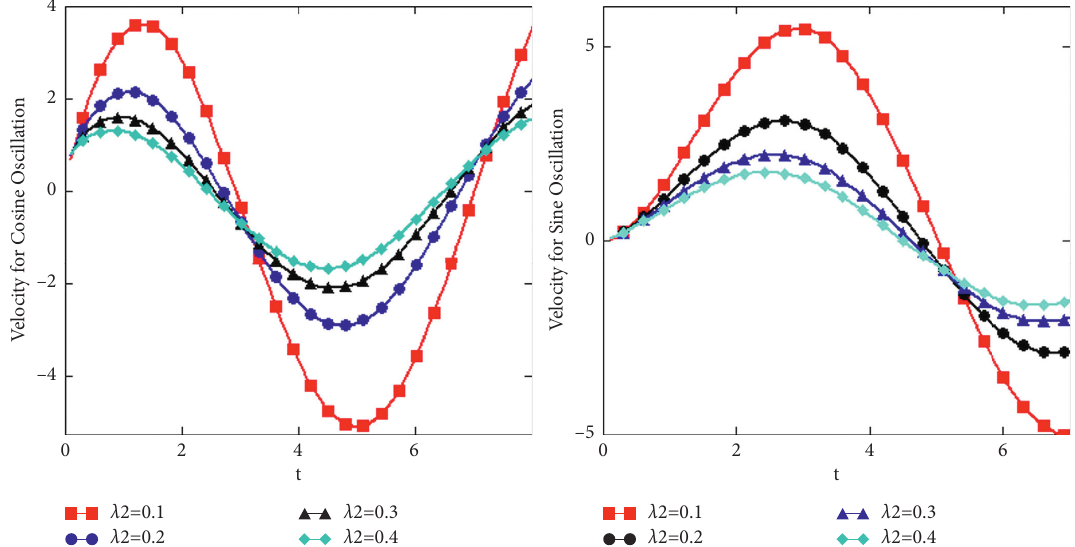
Figure 5: The variation of λ